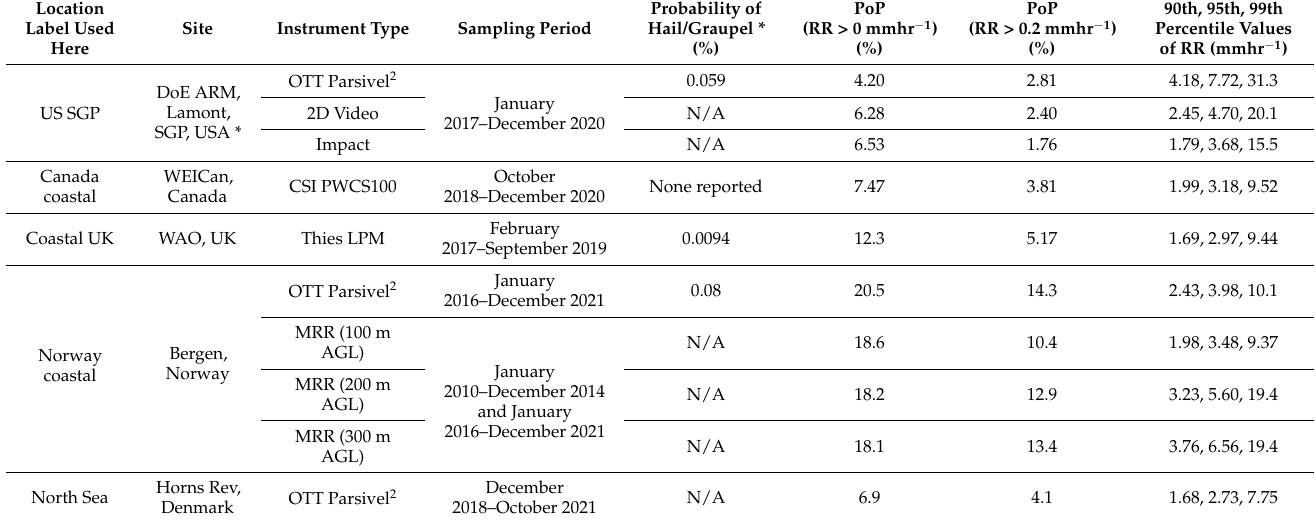
Table 2. Summary of precipitation statistics at the six primary long-term study sites for all available instruments. PoP denotes probability of precipitation and is computed using two different rainfall rate (RR) thresholds. * The values for the three disdrometers at US SGP reflect all 1 min periods when all three instruments reported valid data. Probability of hail/graupel is defined using hail as Weather Codes (WC) 87, 88, 89, 90, except for Bergen where the OTT Parsivel 2 indicates a very high prevalence of WC 87 or WC 88 (2.8% of all observations have one of these two codes). Unless otherwise stated the sampling intervals over which the data are averaged is 1-min. See DSD for these sites in Figures